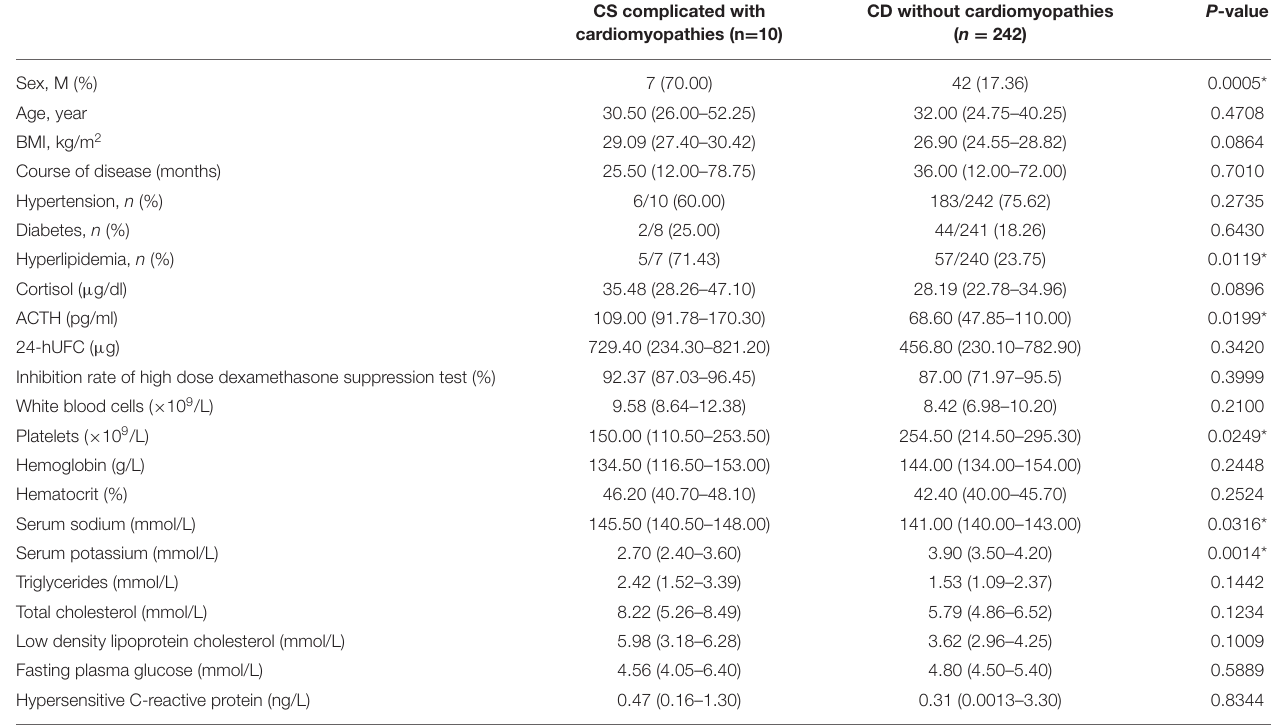
TABLE 4 | Comparison between patients with CS complicated with cardiomyopathies and CD patients without cardiomyopathies.